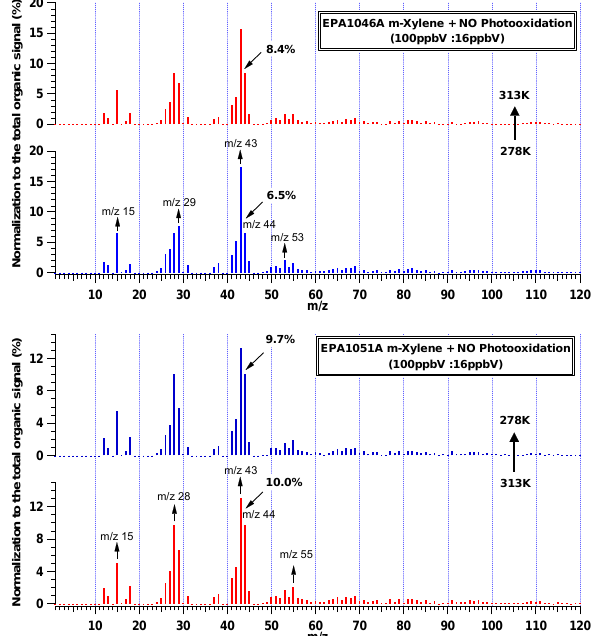
Fig.5 The normalized average mass spectra of total organics for m -xylene photooxidation experiment at two temperatures (278 K, 313 K).